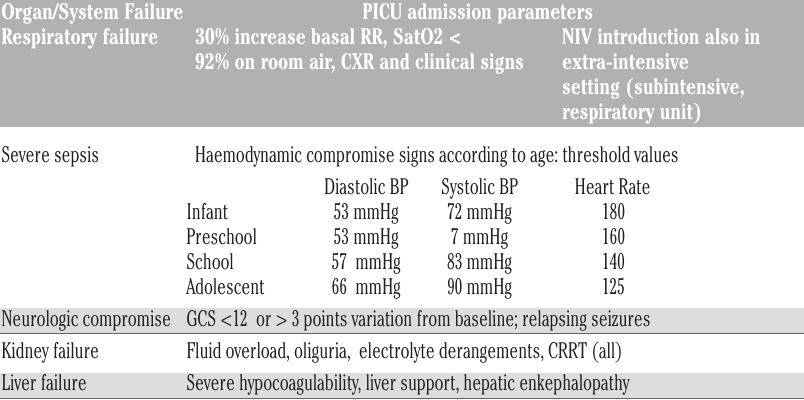
Table 1. Organ failure signs triggering Intensive Care Unit team assessment and possi- bly Intensive Care Unit admission/treatment in H&O pediatric patient. Organ/System